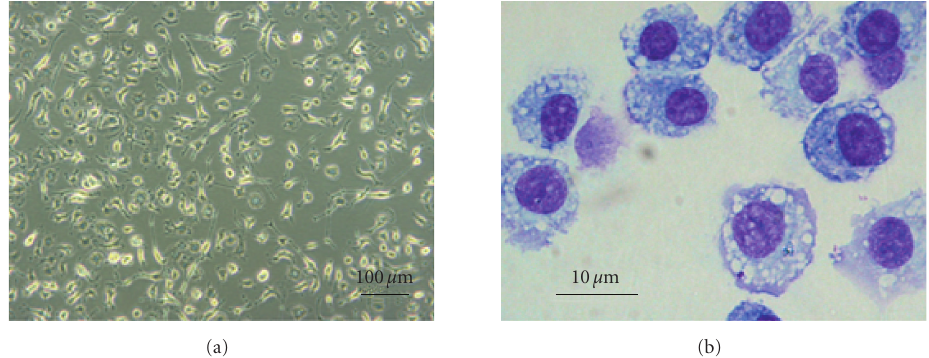
Figure 5: Analysis of Tie-2 expressing monocytes by (a) culture morphology (light microscopy × 100) and (b) Giemsa staining (light microscopy ×